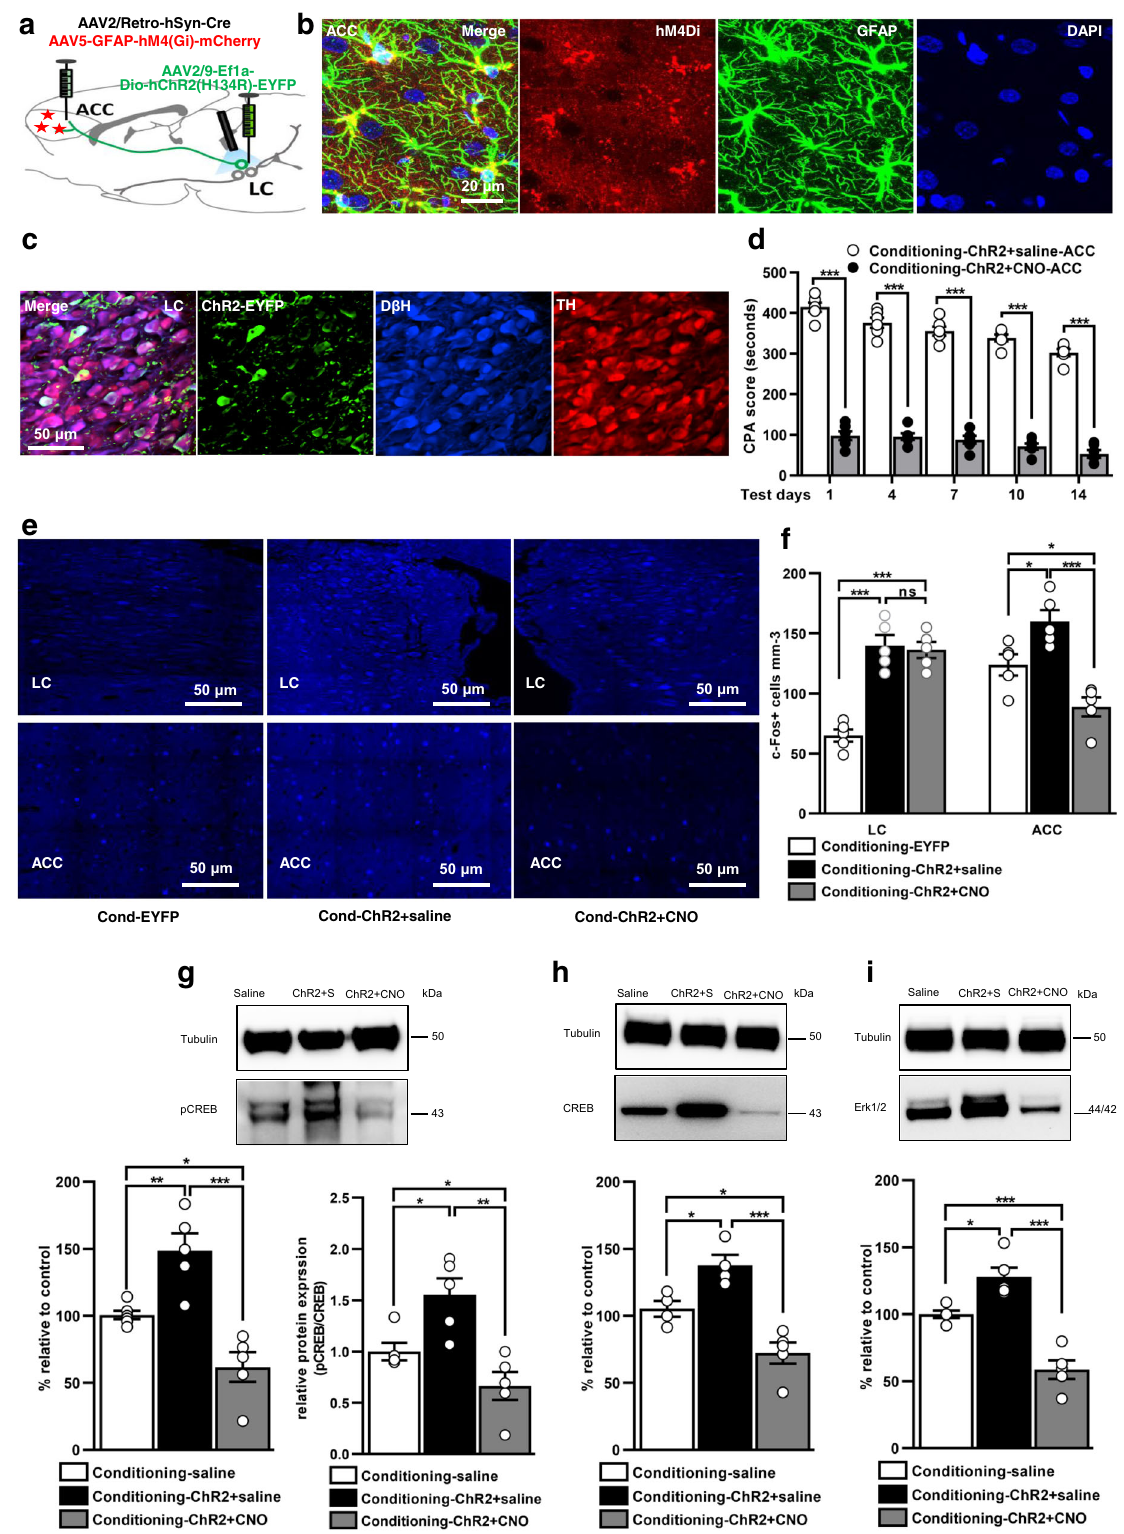
proper diffusion of the virus and slowly withdrawn. The following stereotaxic coordinates AP = 2.8 mm, 0.8mm lateral from bregma, and 2.8mm ventral from the surface of the skull were used 32 . The control groups were transfected with the same volume of control virus AAV2/5-gfaABC1D-eGFP-WPRE-pA (1.1 × 10 13 virus molecules/ml, diluted 1:10 in sterile PBS). The rats received bilateral surgical implantation of chronic fi bre-optic cannula after viral injection at 0.3 mm above the injection site (core diameter 200 μ m and numerical aperture 0.39 NA;